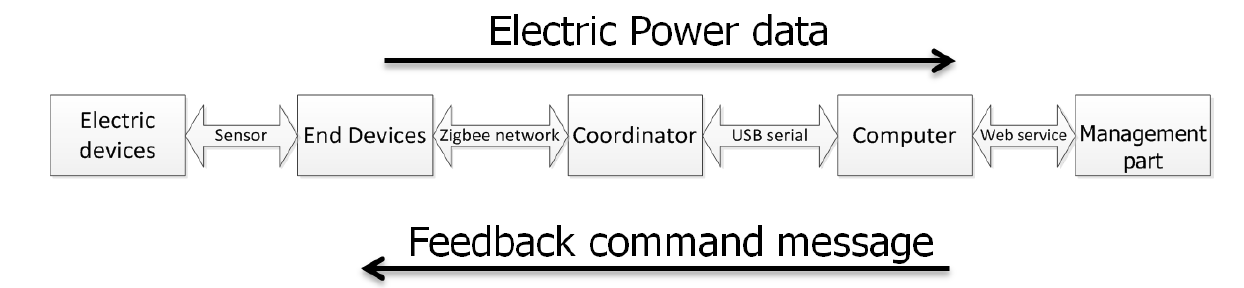
Figure 9. Data flow of the ZigBee